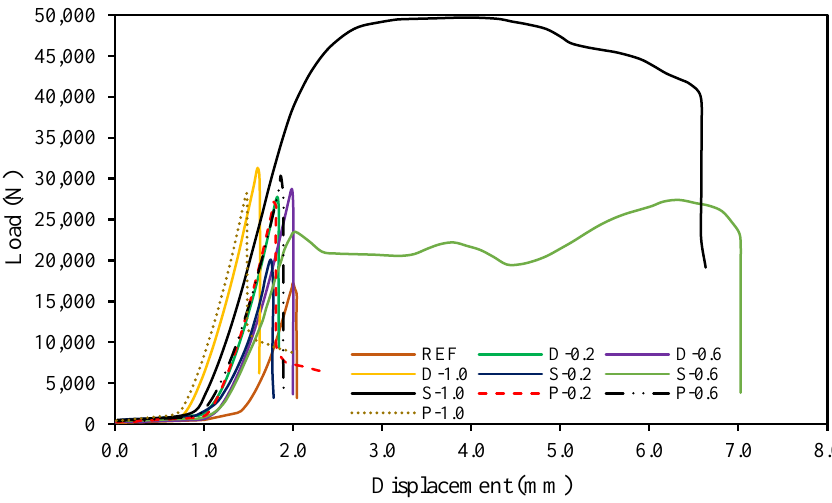
Μd , µs , and µp are the water permeability of the high-strength date palm, steel, and polypropylene fibrous concrete, respectively.